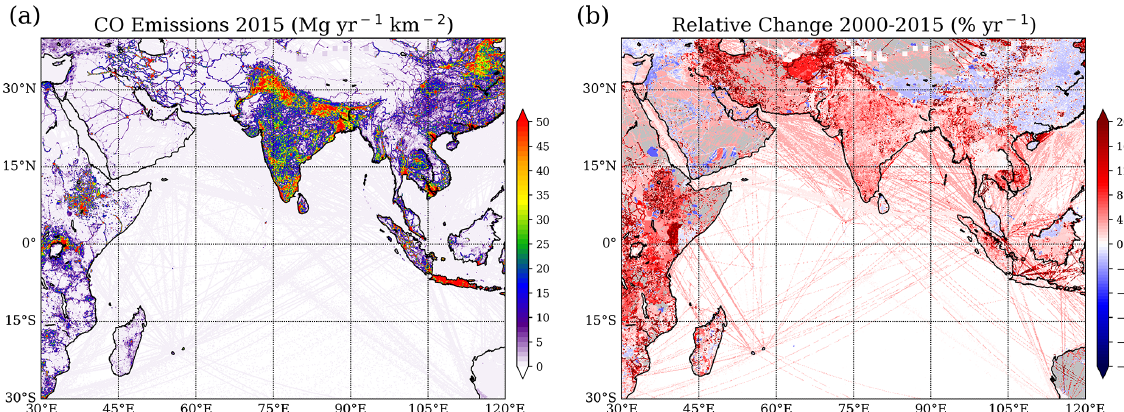
Figure 2. Annual mean CO emissions for 2015 (a) and relative change with respect to 2000 (b) from EDGAR V5.0_AP.